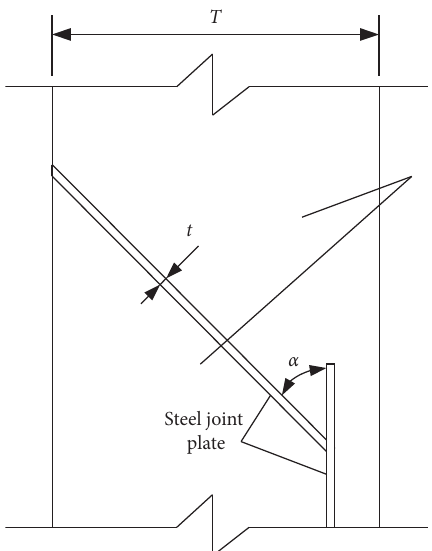
Figure 1: Layout Schematic of the SPRC structure in shaft